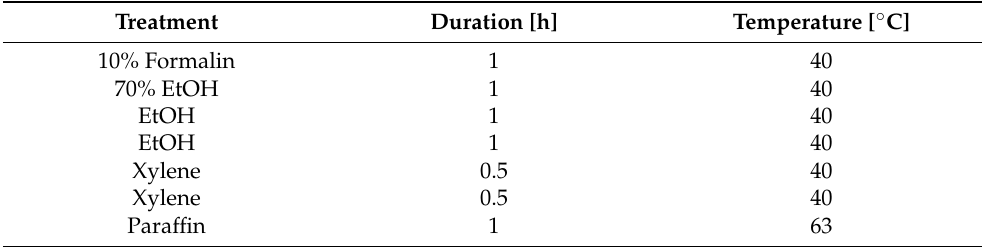
Table 1. Preparation procedure for the paraffin embedding of formalin-fixed